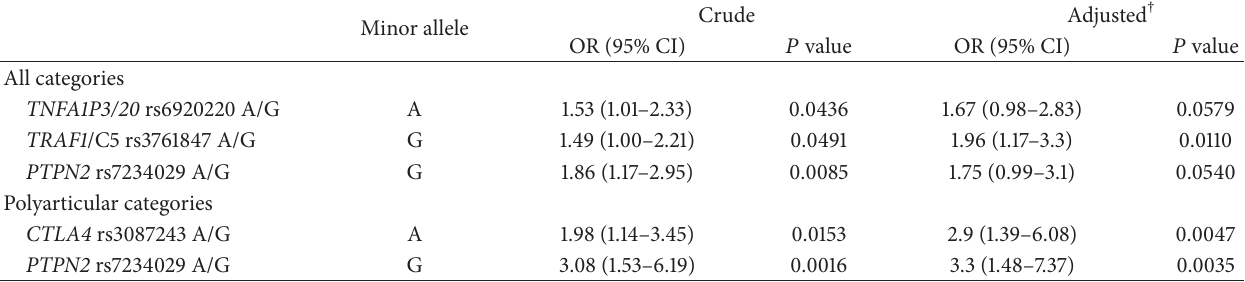
Table 2: Crude and adjusted odds ratio for the association between single nucleotide polymorphisms and poor prognosis. Minor